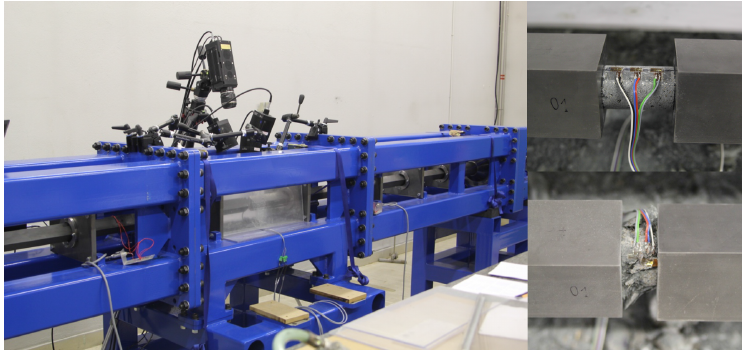
Figure 3. Experimental set-up and specimen appearance before and after